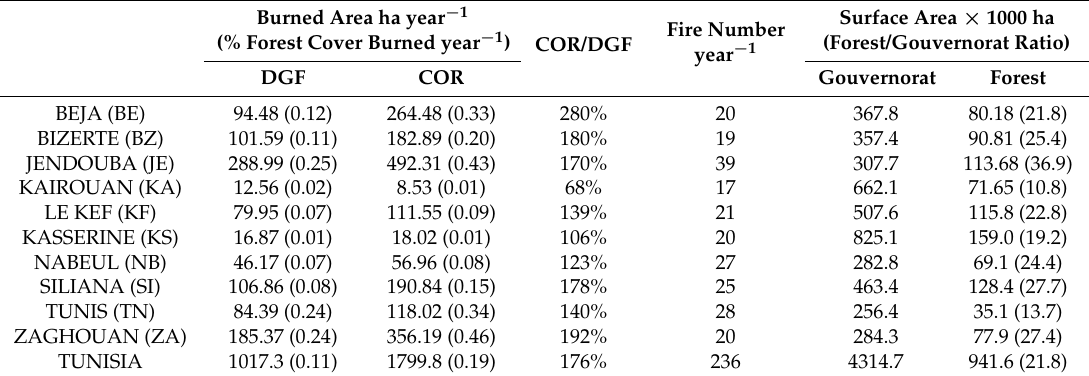
Table 2. Burned area and fire number synthesis for each gouvernorat in Tunisia from the official DGF ( Direction G é n é rale des For ê ts ) database and the corrected database (COR). The COR/DGF ratio represents the error in the official data. Surface area of gouvernorat (in ha), forest and shrubland cover (in ha) are also shown and used to derive the percentage of forest cover burned per year for each gouvernorat and Tunisia.